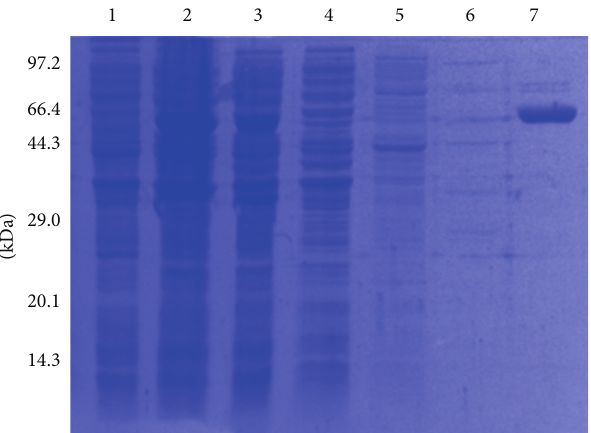
Figure 2: Expression and purification of Lon-like-Ms from E. coli . Molecular mass standards are indicated at left. Lane 1, crude protein extract from noninduced cells; Lane 2, crude protein extract from IPTG-induced cells; Lane 3, soluble extract from IPTG-induced cells; Lane 4, unbound proteins eluted from the Ni-NTA column; Lane 5, proteins eluted with 5mM imidazole; Lane 6, proteins eluted with 10mM imidazole; Lane 7, proteins eluted with 300mM